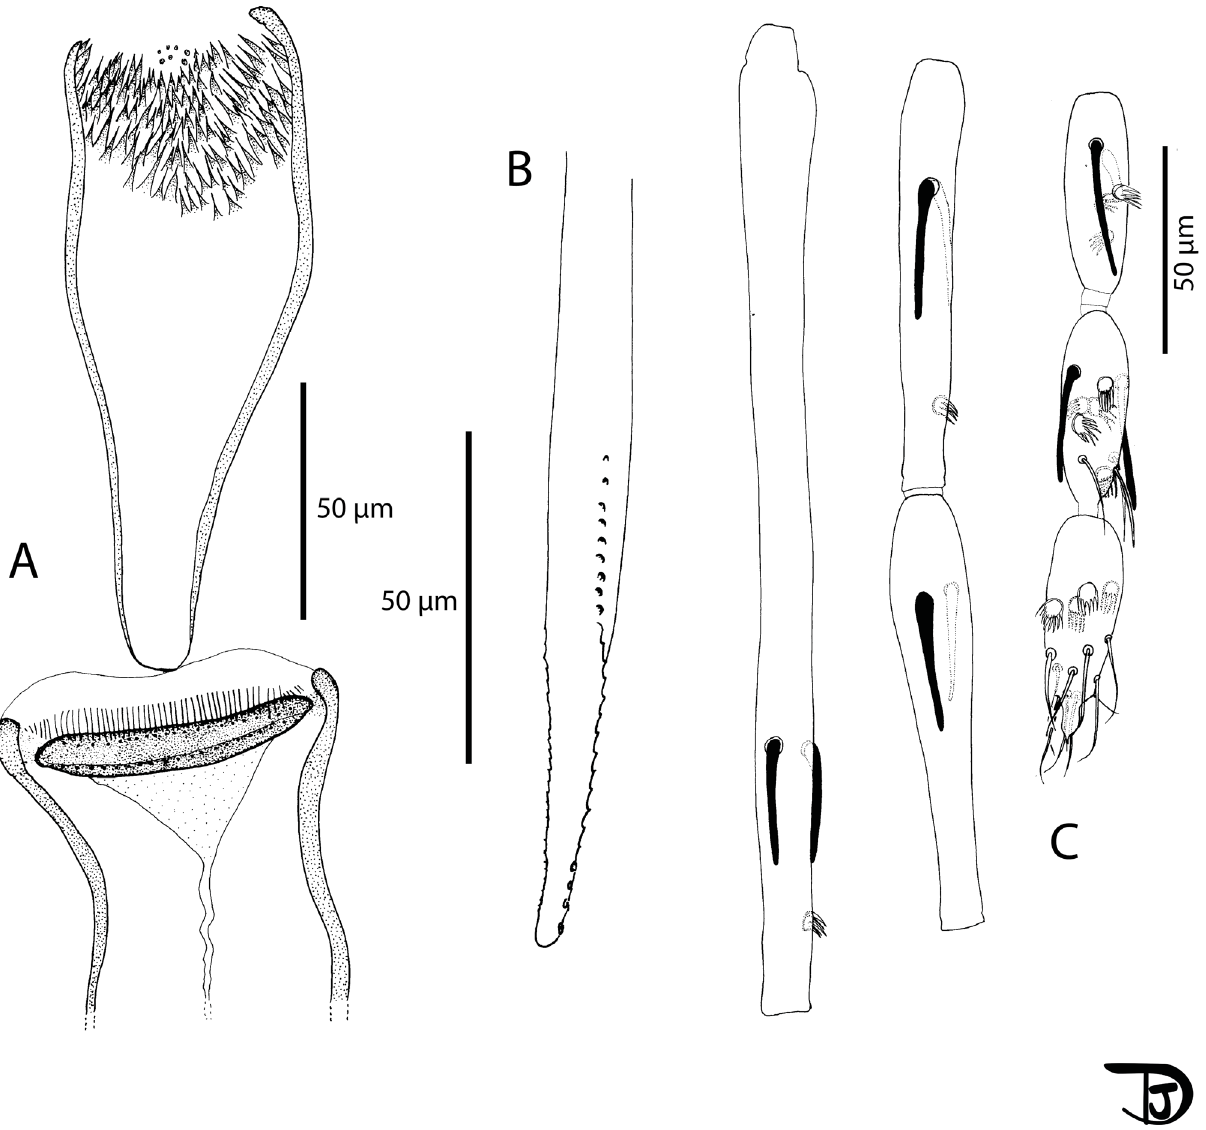
Figure 14. Sergentomyia (Riouxomyia) kaltenbachi n. sp. female (holotype MADA728). (A) pharynx and cibarium, (B) maxilla, (C) fl agellomeres 1, 2, 3, 12, 13 and